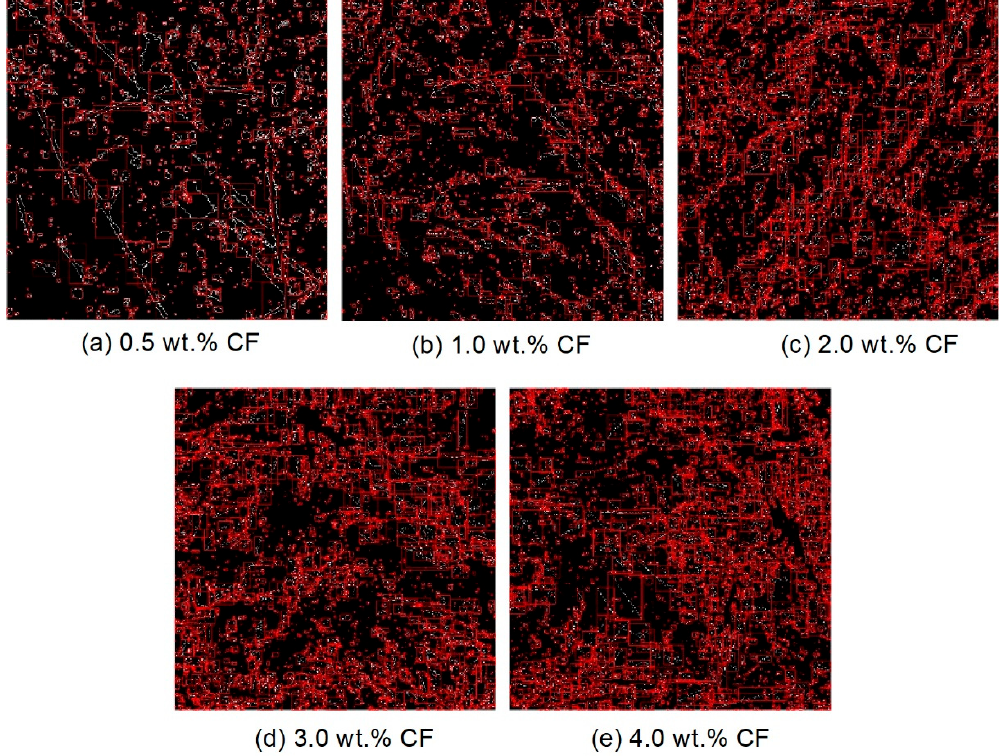
Figure 14. Fiber orientation binary image of the contact-hardening composites with different fiber contents using an external area rectangle (EAR): ( a ) 0.5 wt.%; ( b ) 1.0 wt.%; ( c ) 2.0 wt.%; ( d ) 3.0 wt.%; ( e ) 4.0 wt.%.